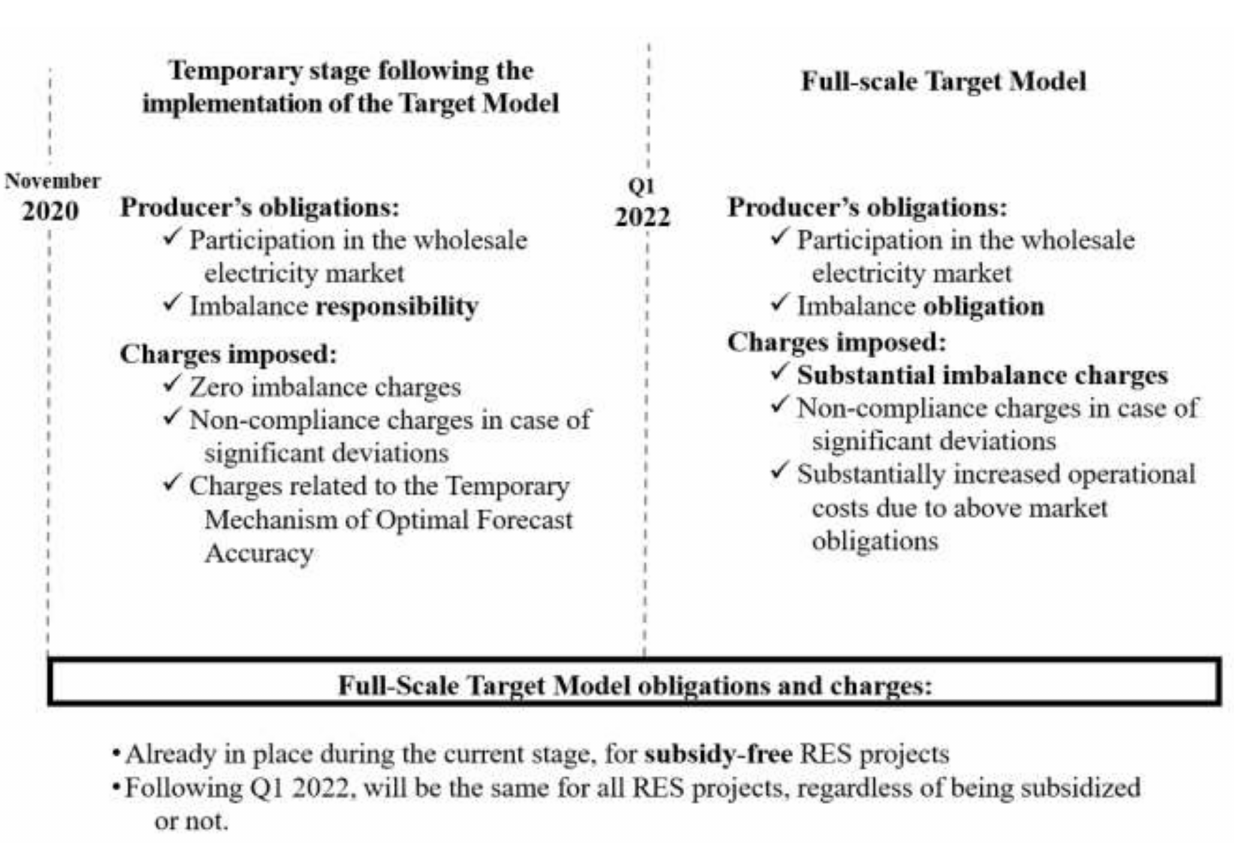
Figure 18. New RES Framework under the Target Model in Greece, Source: Hellenic Energy Exchange and Authors’ estimations.